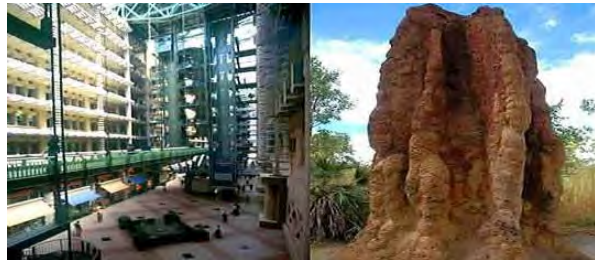
Figure 7. To show the extent that designer applied mimicry of termite mounds